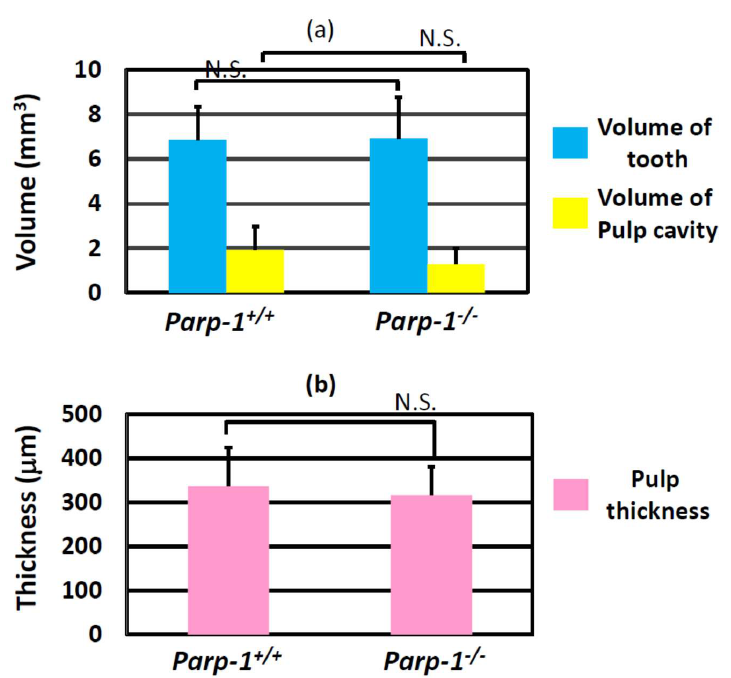
Figure 5. The volume analysis of tooth, pulp cavity, and pulp thickness of incisors of aged Parp-1 +/+ and Parp-1 −/− mice (C57BL/6). ( a ) Tooth and pulp cavity volumes of incisors of Parp-1 +/+ and Parp-1 −/− mice. ( b ) Pulp thickness of Parp-1 +/+ and Parp-1 −/− mice. Six Parp-1 +/+ mice and ten Parp-1 −/− mice were mice. ( b ) Pulp thickness of Parp-1 +/+ and Parp-1 − / − mice. Six Parp-1 +/+ mice and ten Parp-1 − / − mice